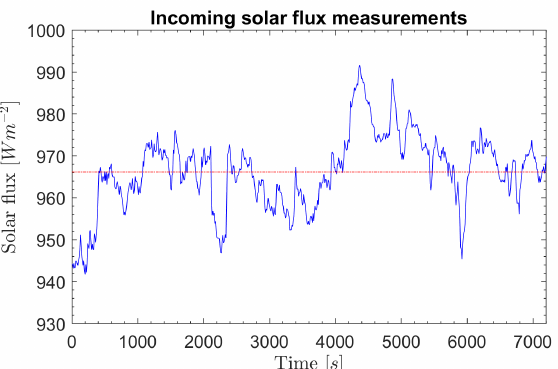
Figure 3. Incoming solar flux of the experimental study for validation. The red line indicates the time-averaged